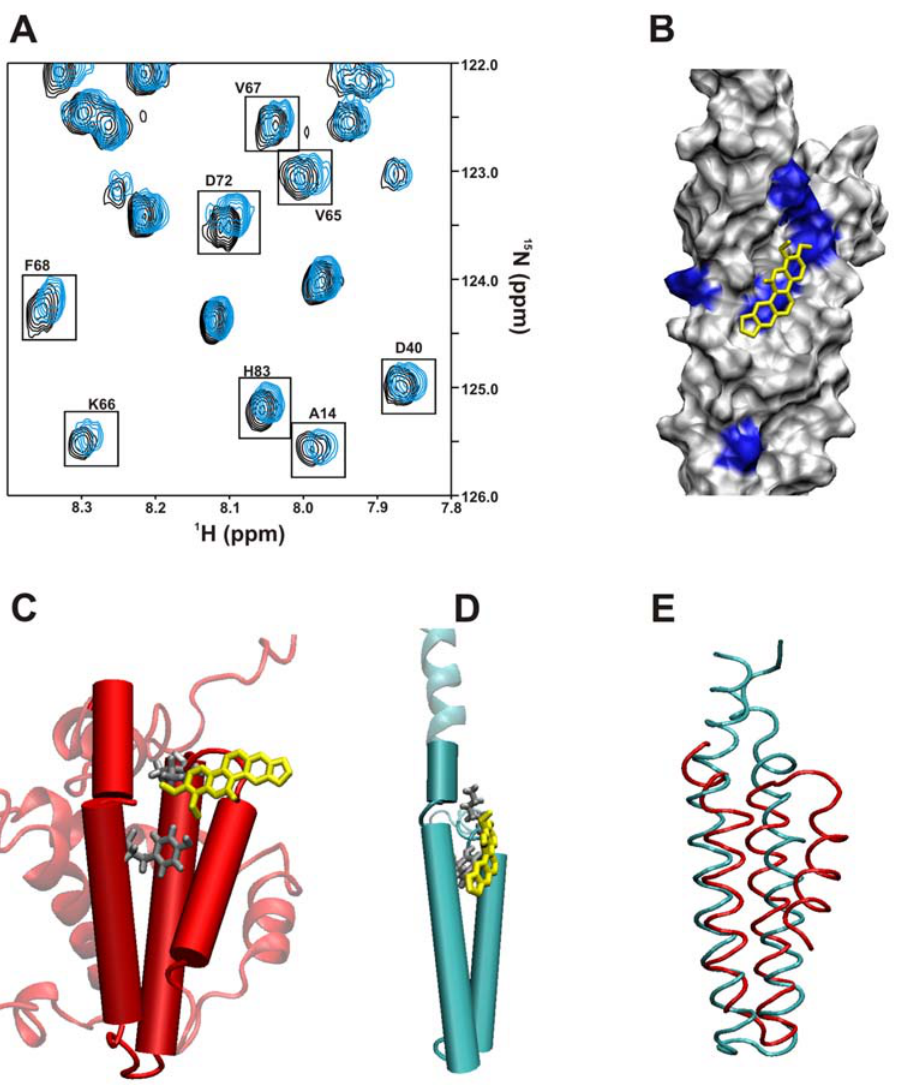
Figure 3. Verification that the Bcl-xL inhibitor chelerythrine also binds PrgI. (A). Expanded overlay of the 2D 15 N- 1 H HSQC spectra for free PrgI (black) and PrgI bound to chelerythrine (blue). CSPs greater than one standard deviation are boxed. (B) An AutoDock/ADF docked structure of PrgI complexed with chelerythrine based on the observed CSPs from (A). (C) The Bcl-xL region shown to bind chelerythrine is highlighted while the remaining protein structure is transparent. Chelerythrine is colored yellow and is drawn with licorice bonds. Side-chains for Y173 and V135 are shown as licorice bonds and colored grey. (D) A ribbon diagram of the AutoDock/ADF docked PrgI-chelerythrine co-structure. The PrgI-chelerythrine binding region that overlaps with Bcl-xL is highlighted. Chelerythrine is colored yellow and is drawn with licorice bonds. Side-chains for Y57 and K15 are shown as licorice bonds and colored grey. (E) An expanded view of the overlay of Bcl-xL (red) with PrgI (blue) illustrating the structural similarity of the chelerythrine binding